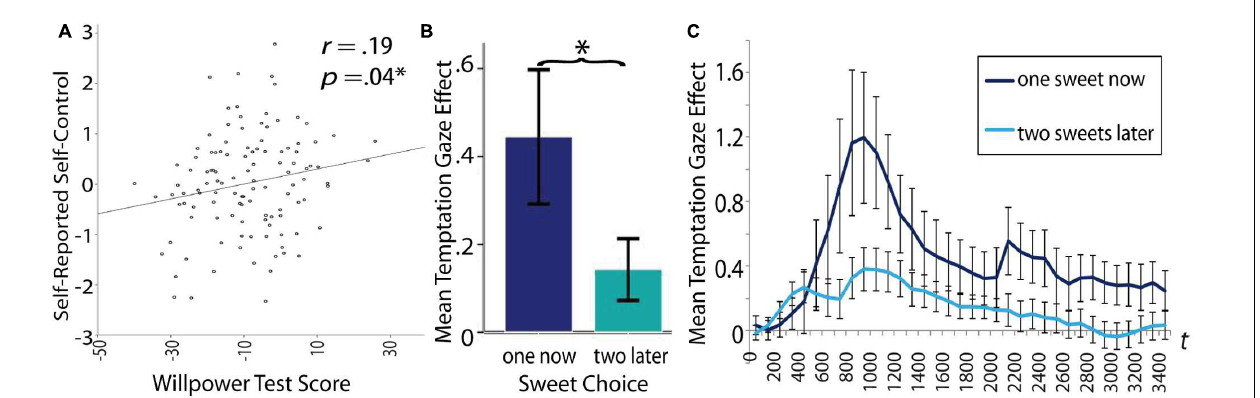
FIGURE 4 | Display of the association between different willpower measures. (A) positive correlation between the total willpower task score and self-reported willpower, (B) the mean gaze distance temptation effect (distance from target letter in trials with erotic distractors minus distance in neutral trials) was significantly